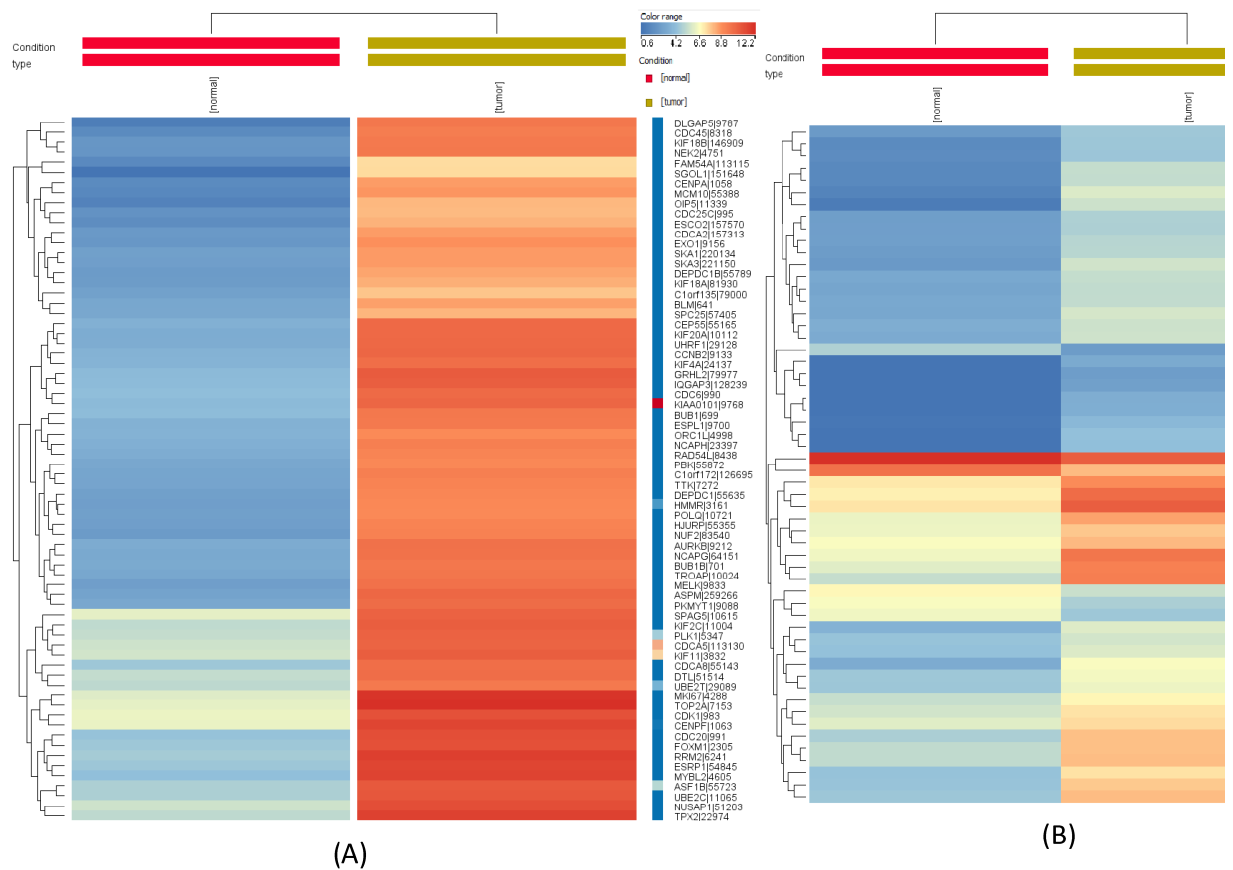
Figure 1. Heatmap for ( A ) gene expression alterations in tumor vs. peritumoral tissue; ( B ) miRNA expres- sion alterations in tumor vs. peritumoral tissue (the red frame shows miR-205-5p as being